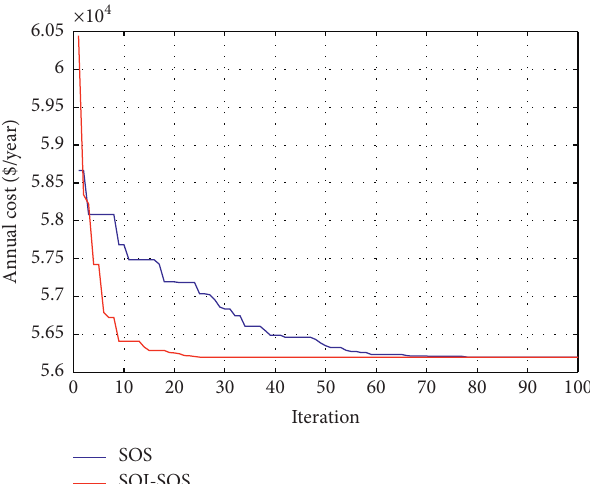
Figure 2: Convergence curves of the total cost of the 33-bus system under the CP load model with 100% loading.